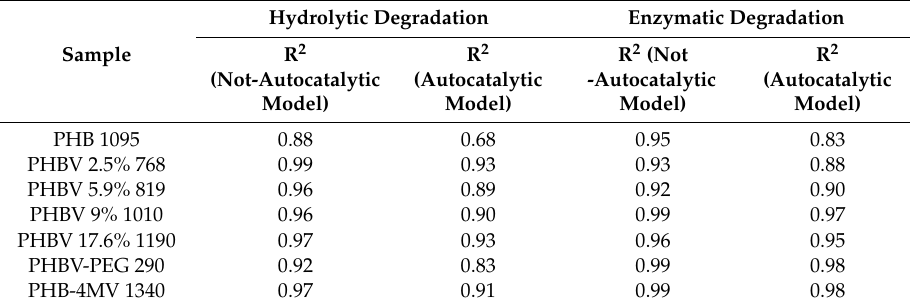
Table 2. Correlation coe ffi cients of a not-autocatalytic and autocatalytic degradation models.